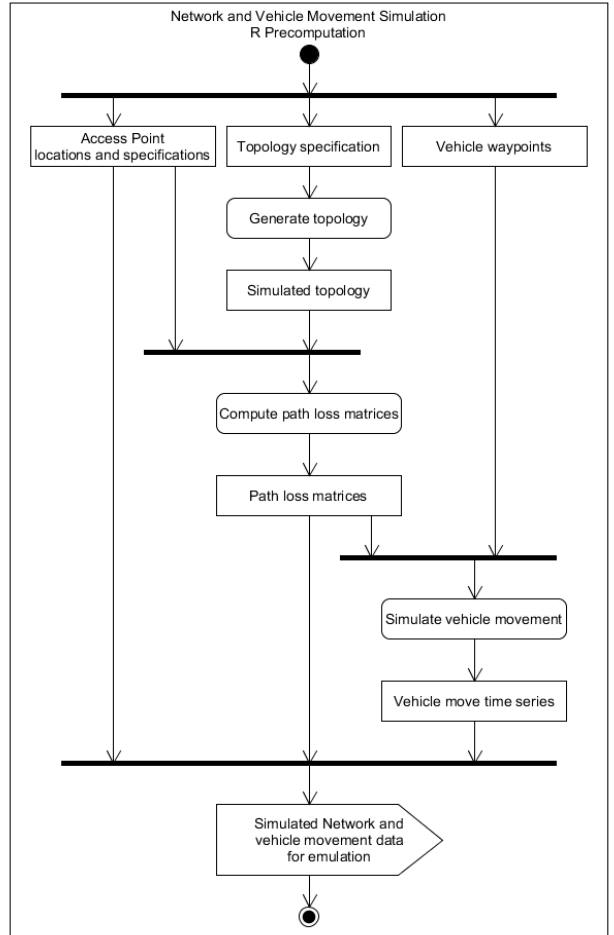
Figure 9. Activity diagram for the creation of network and vehicle movement simulation data for emulation purposes.